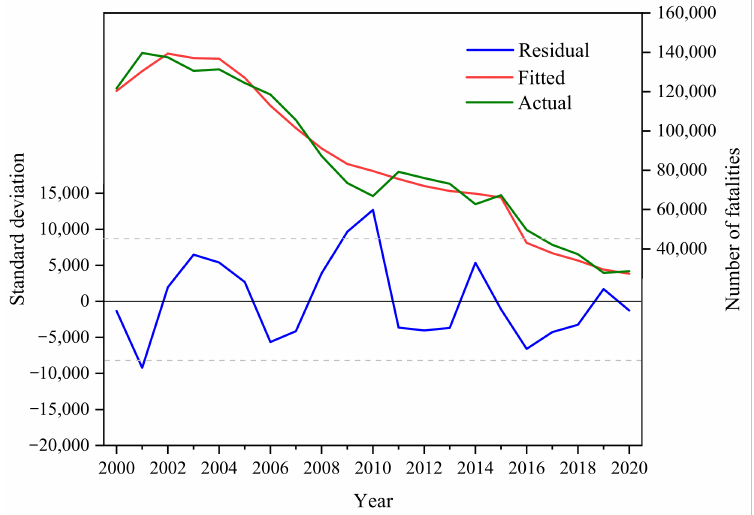
Figure 3. Residual